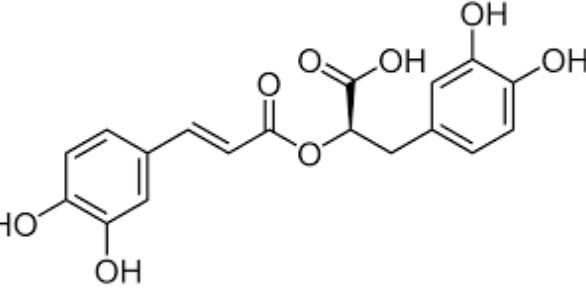
Figure 1. Chemical structure of rosmarinic acid (RA).